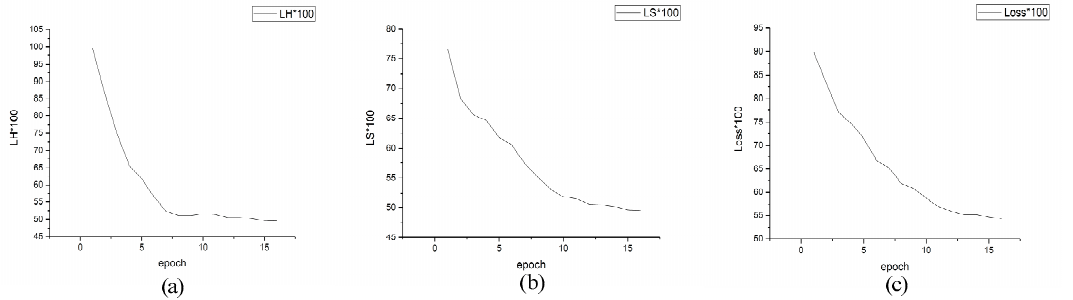
Figure 8. Loss function performance curve: ( a ) the curve of LH ; ( b ) the curve of LS ; ( c ) the curve of loss. The loss value for each pass is the average after training all images.